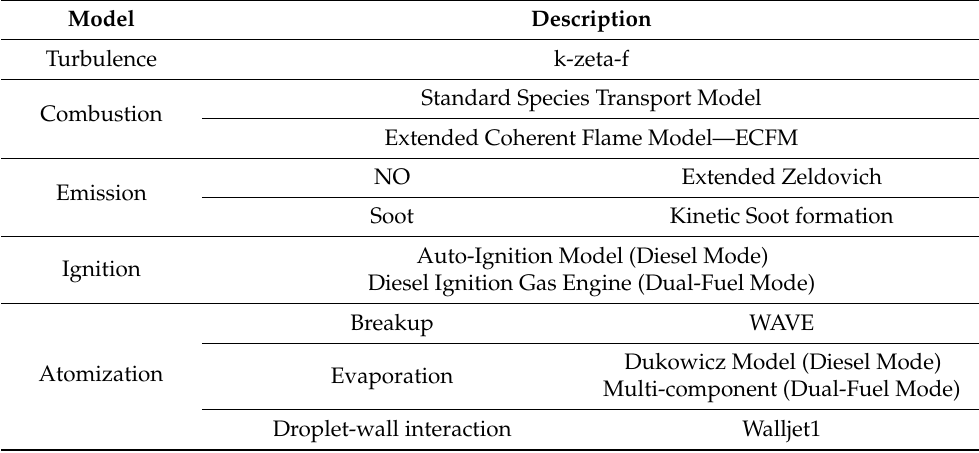
Table 2. Summary of the numerical models.